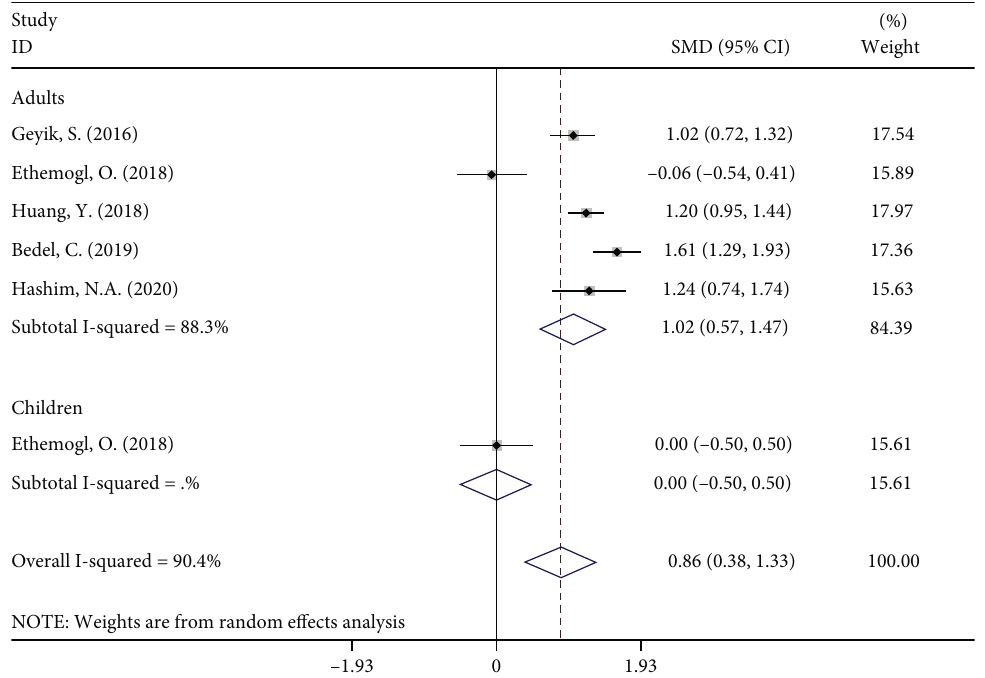
Figure 3: Subgroup analysis of di ff erences in NLR levels between GBS patients before treatment and healthy controls according to age